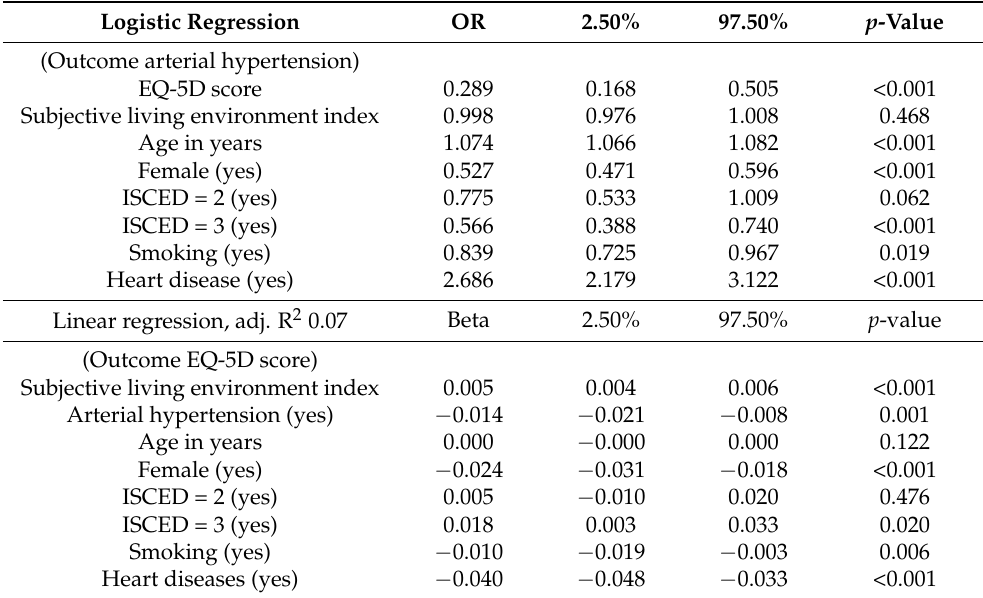
Table 5. Results logistic (outcome is arterial hypertension) and linear (outcome is quality of life) regression